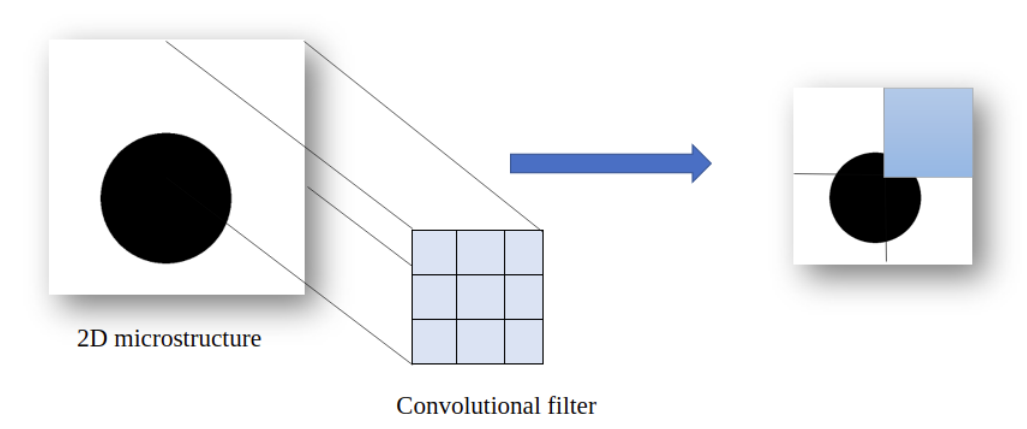
Figure 6. Detection of the important features of the 2D microstructure using the different filters of convolutional